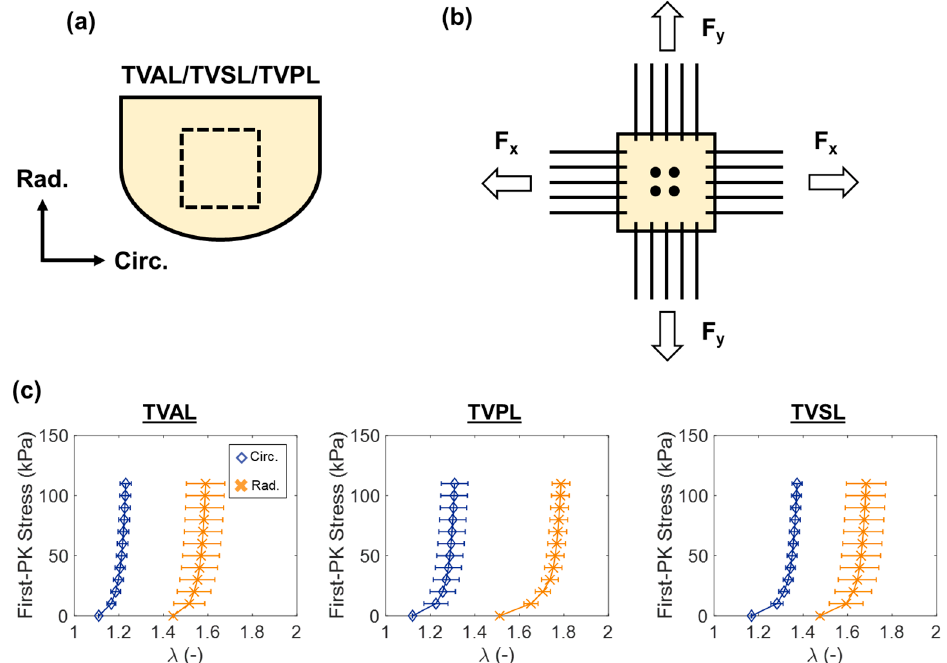
Figure 8. ( a ) Schematic of the excised leaflet tissue and the central bulk region taken from the TVAL, TVPL, or TVSL. ( b ) An illustration of the mounted TV leaflet tissue specimen onto the biaxial testing system with the collagen fiber orientations (circumferential and radial directions) aligned with the testing x - and y -directions. ( c ) Mean ± SEM of the first-PK stress versus stretch results of the porcine TVAL, TVPL, and TVSL tissues ( n = 6) under equibiaxial loading protocol ( F x : F y = 1:1) at room temperature (22 °C). Images were modified from Jett et al. (2018) [46].